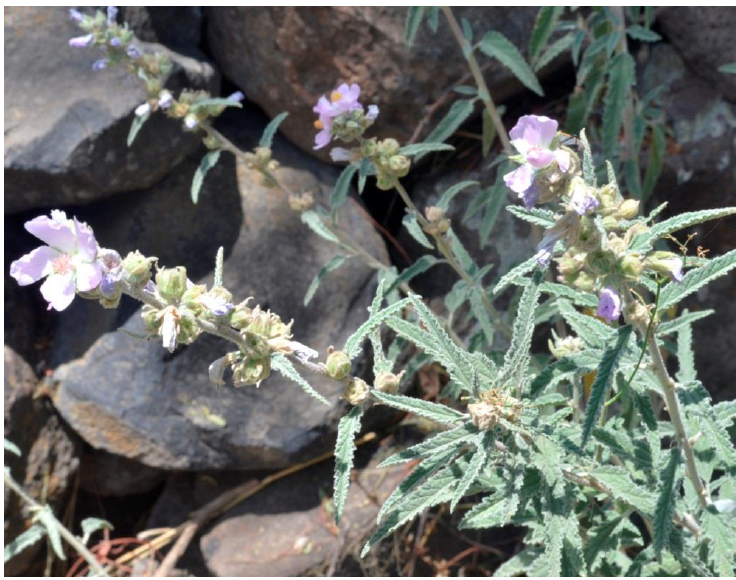
Figure 1. Sphaeralcea angustifolia wild plant growing in the municipality of Huichapan, Hidalgo State, Mexico.